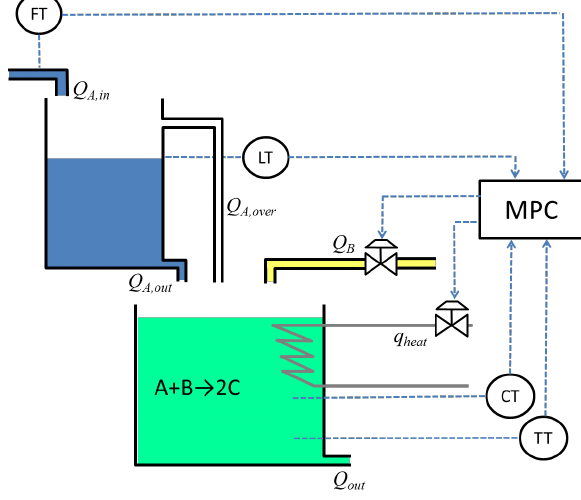
Figure 14. A schematic showing the MPC scheme of a CSTR and surge tank with